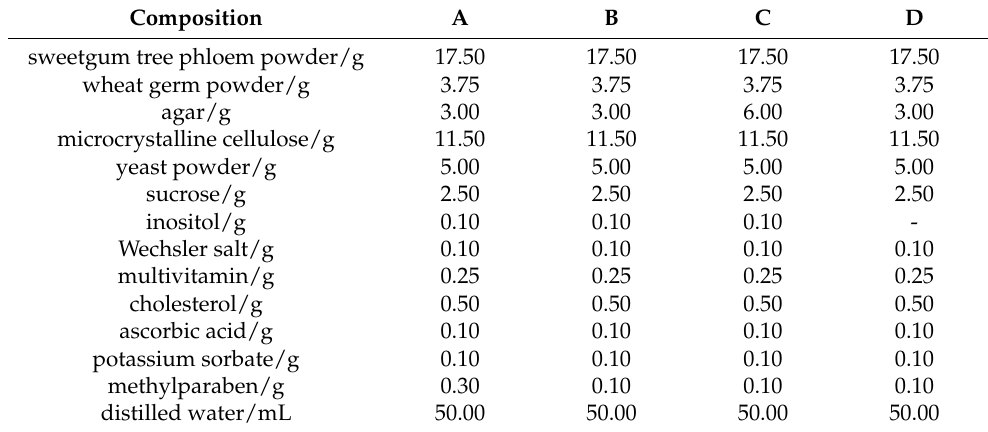
Table 1. Formulas of artificial diets for rearing the larvae of Acanthotomicus suncei . Composition A B sweetgum tree phloem